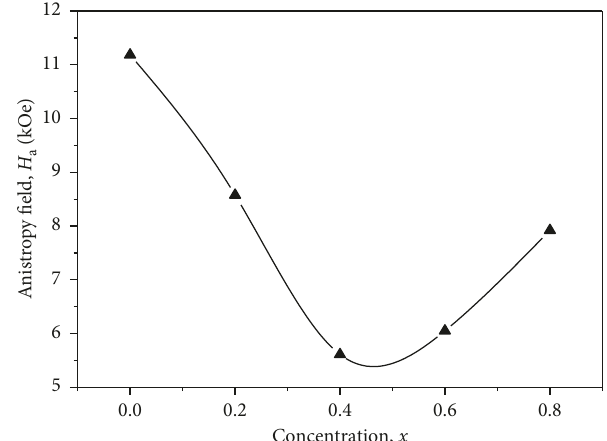
Figure 7: The anisotropy field as a function of Zn concentration ( x